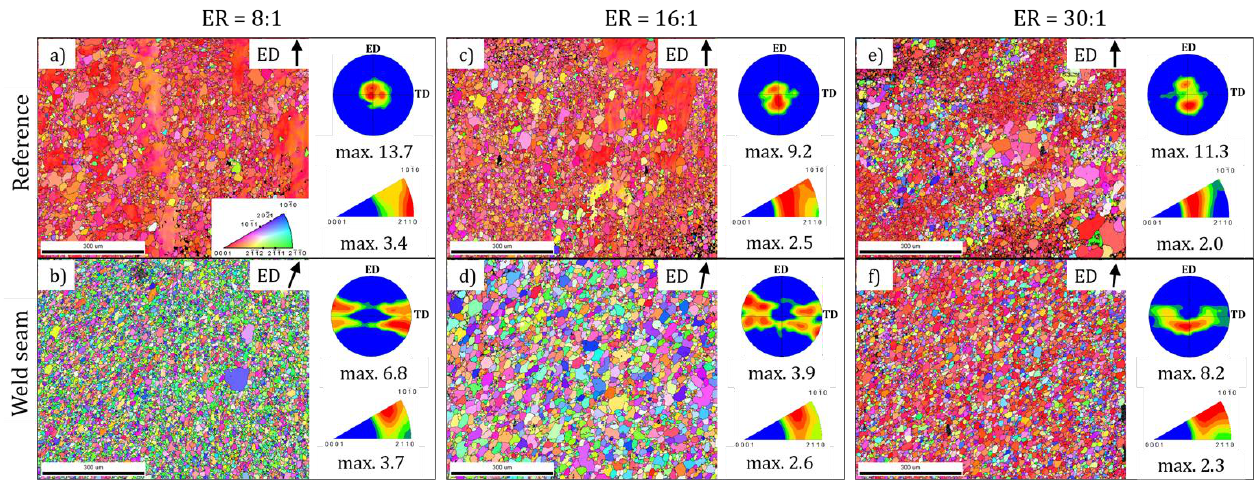
Figure 2. IPF-maps and {0001}-pole figures of the reference area with the corresponding weld seam area, electron backscatter diffraction (EBSD) measurements on flat sections of samples from profiles extruded at TB = 450 °C and vProd = 1 m/min, ( a , b ) ER = 8:1, ( c , d ) ER = 16:1, ( e , f ) ER = 30:1, processed to the ND.